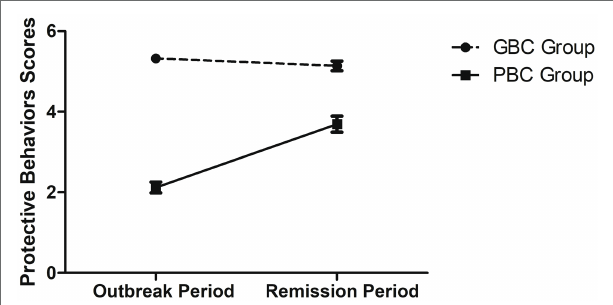
FIGURE 3 | Scores of protective behaviors in the outbreak and remission periods for the Good Behavioral Coping (GBC) group and the Poor Behavioral Coping (PBC) group. Error bar presents standard error of the